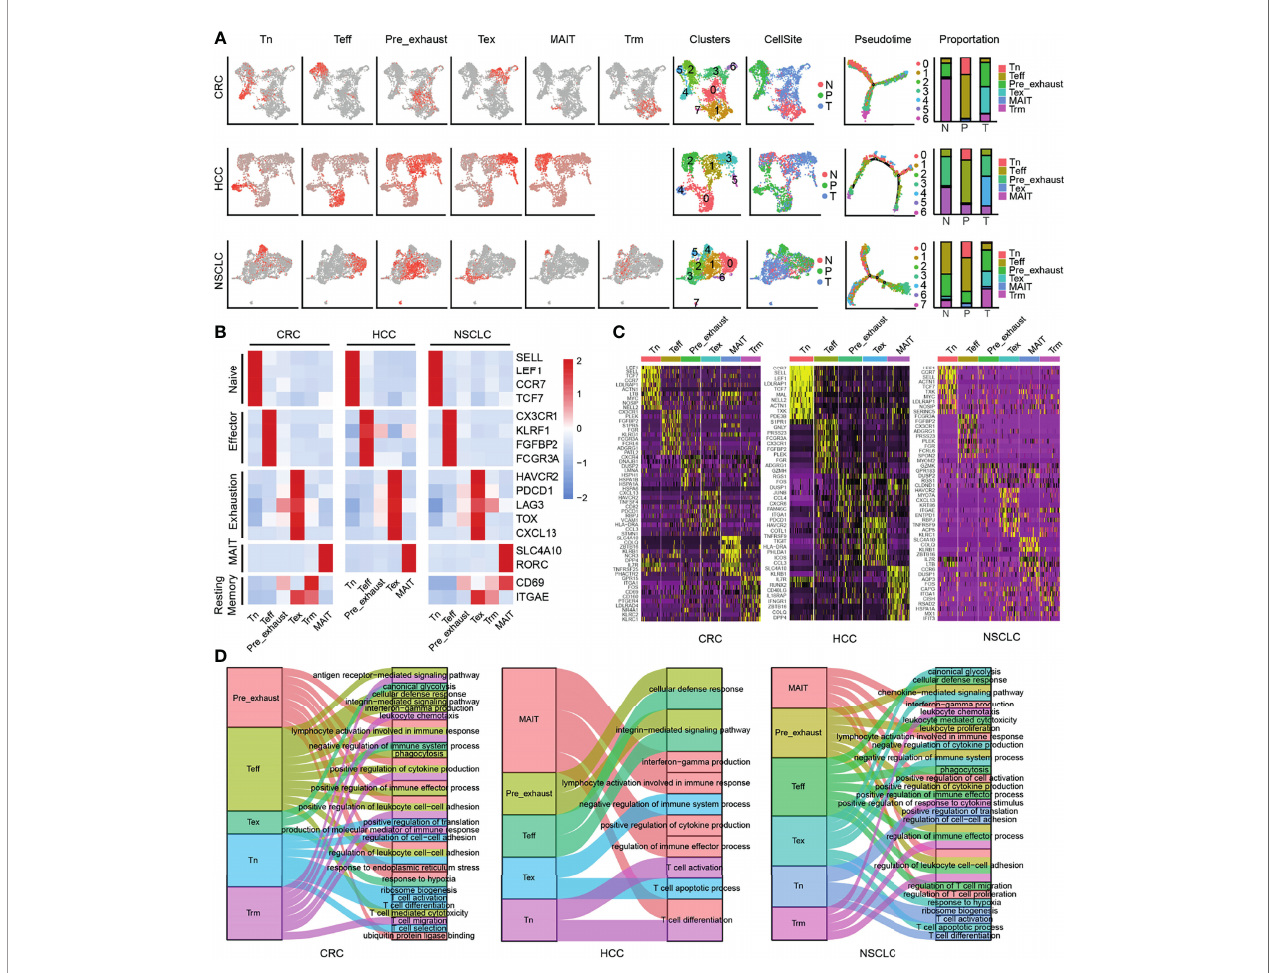
FIGURE 1 | Clustering of CD8+ T cells in three cancers. (A) UMAP of single cells to visualize cell-type clusters (left), Pseudo-time trajectory graph (middle), and the proportion of different cell types in different sources (right). (B) Heatmap showing marker genes for CD8+ cell types. (C) The top 10 DEGs in each cell type in three cancers. (D) The GO enrichment analysis of different cell types of CD8+ T cells in three